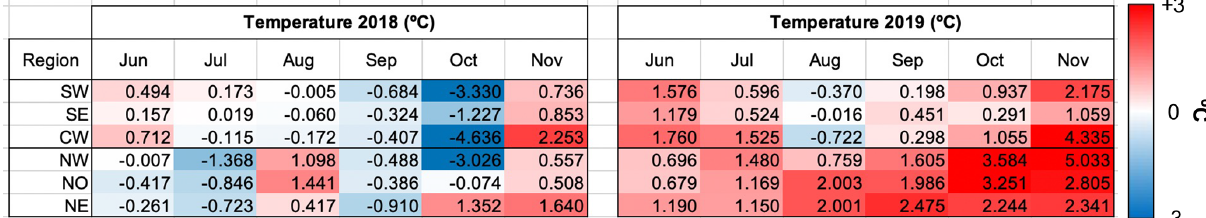
Figure B4. June through November monthly temperature anomalies below 2500m ( ◦ C) from the 1958–2017 mean climatology for each subregion of the GrIS in 2018 and